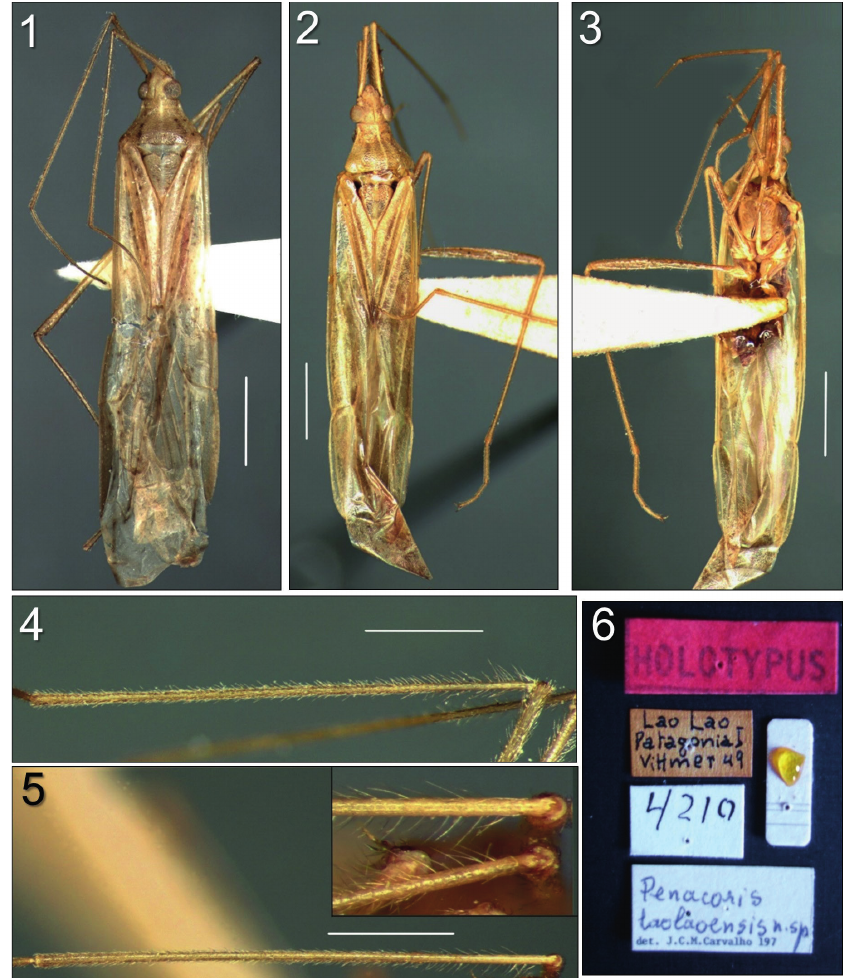
pubescence, hind femora without spines and hind tibiae covered with hairs as long or more than width of segment. Ratio of antennal segments: 1: 2.27: 1.33: 0.88. Head across eyes 1.12 times wider than head length. length of segment I of antenna 1.87 times longer than width of head width across eyes. Rostrum 3.1 times longer than head across eyes. Pronotum width 1.63 times longer than pronotum length. Hind femora 1.56 times as long as fore femora, and 1.70 times as long as middle